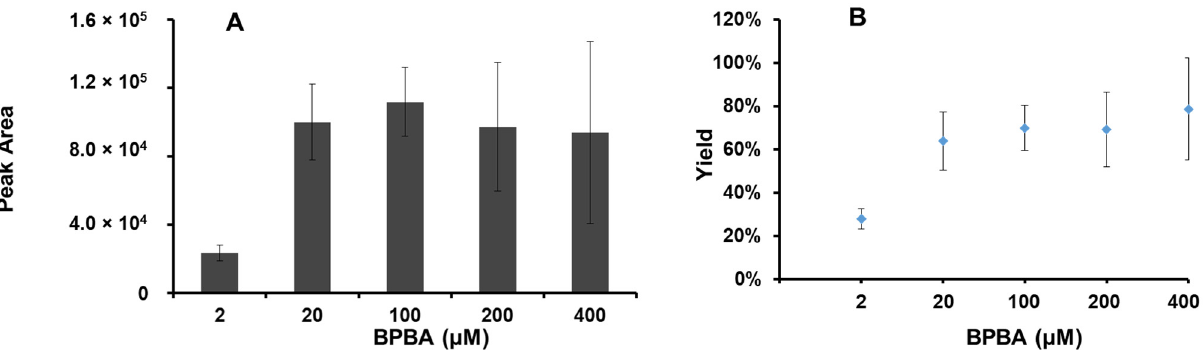
Figure 3. Optimization of post column derivatization reaction using different concentration of BPBA. ( A ) Signal of BPBA labeled 14,15-DiHETrE; ( B ) Yield of BPBA labeled 14,15-DiHETrE.